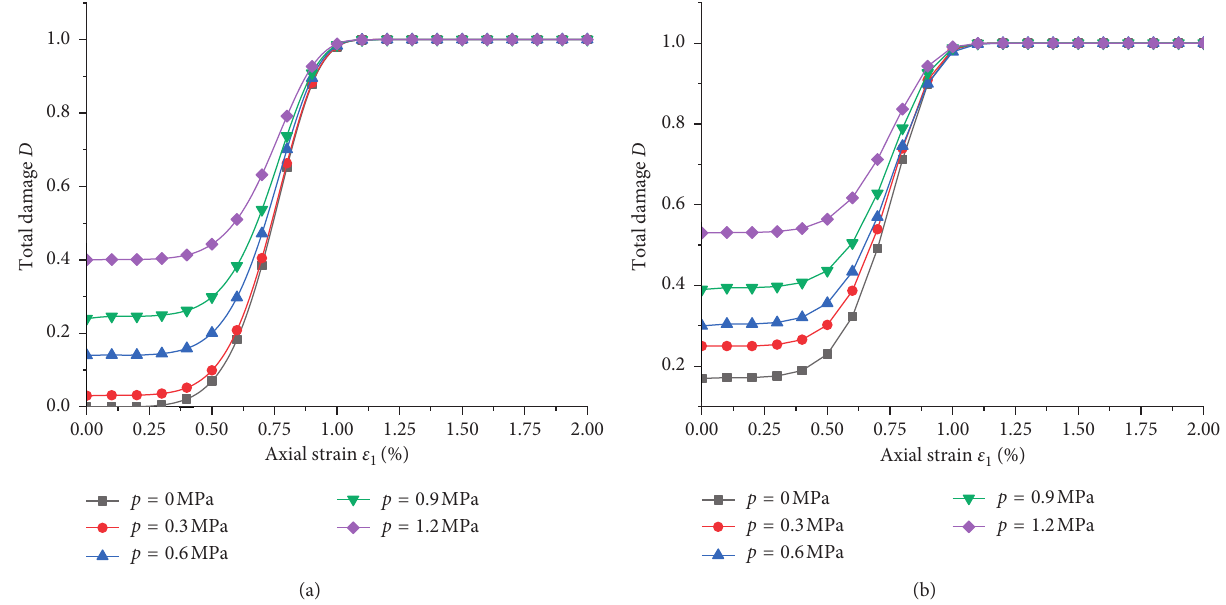
Figure 6: Damage evolution curves of backfill under different seepage water pressures. (a) Intact backfill. (b) Backfill with prefabricated